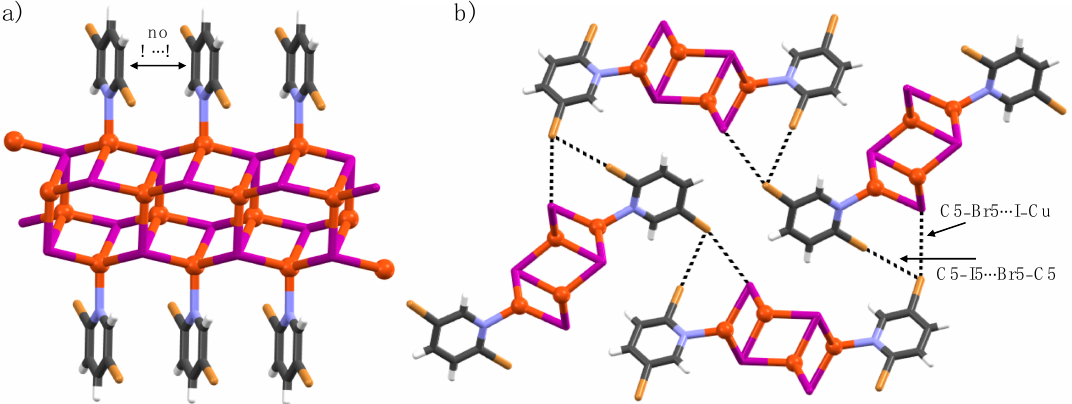
Figure 6. ( a ) X-Ray crystal structure of 6a , and ( b ) section of crystal packing displaying halogen bonds. Halogen bonds are depicted by black dotted lines.